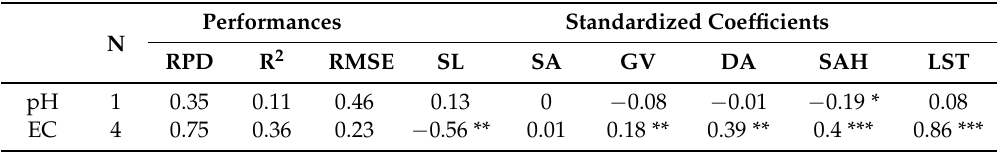
Figure 4. Cross-validation results of PLSR. RMSEP: root mean square predicted residual error. Table 4. Performance statistics, standardized coefficients, and bootstrap tests of PLSR calibration models. RPD: ratio of prediction to deviation.